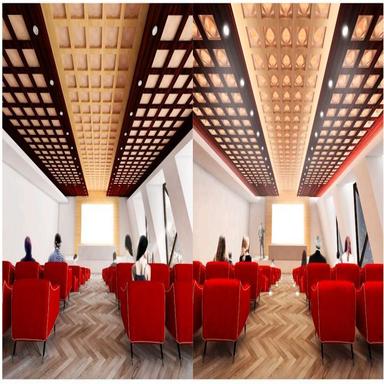
Simulation of the conference room when relative humidity is ≈ 50% (left, panels closed) and when it is higher (right, panels opened).